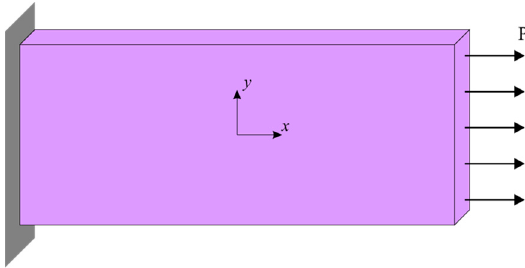
Figure 6. Crystal model for static analysis.